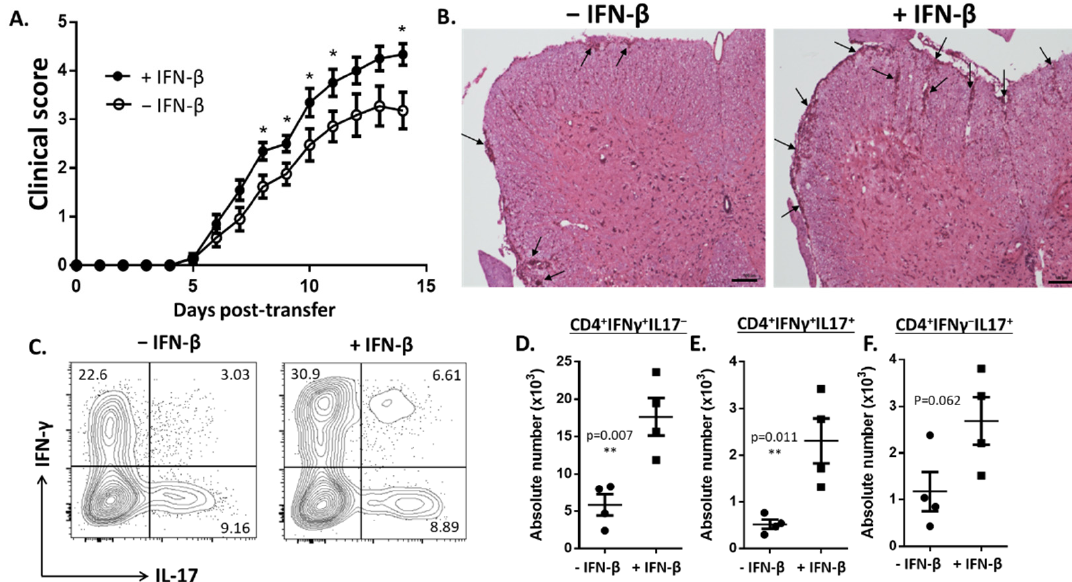
Figure 1. IFN- β increases the pathogenicity of IL-23-stimulated, myelin-enriched TH17 cells. ( A ) Clinical scores of mice with EAE induced by adoptive transfer of splenocytes cultured with MOG 35–55 , IL-23 and anti-IFN- γ in the presence (+) or absence ( − ) of recombinant mouse IFN- β ( n = 20–21 mice per group from three independent experiments). ( B ) Histology of spinal cord sections from representative mice from the − IFN- β and + IFN- β groups. Sections were obtained 15 days post- transfer and stained with H & E. Arrows indicate demyelinating lesions in the brain and spinal cord. ( C ) Representative flow cytometry plots of CD4+ T cells expressing IFN- γ and IL-17 in the spinal cords of EAE mice, 15 days post-transfer. Absolute numbers of T helper cells that are ( D ) IFN- γ + IL-17 - , ( E ) IFN- γ + IL-17 + and ( F ) IFN- γ - IL-17 + in the spinal cords of EAE mice. Error bars represent means ± s.e.m. Statistical analysis was performed using Mann − Whitney tests. p values < 0.05 were considered significant (** indicates p ≤ 0.01, * indicates p < 0.05).